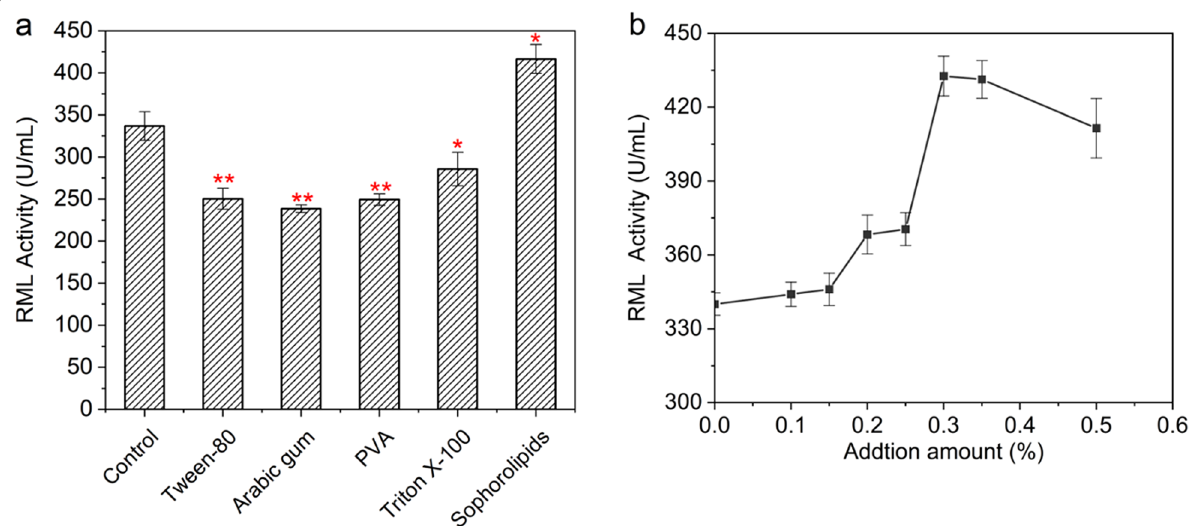
Fig. 1 Selection of the optimal surfactant and its concentration. a Effect of different surfactants on RML activity (*: 0.01 < P Effect of different SLs concentrations on RML